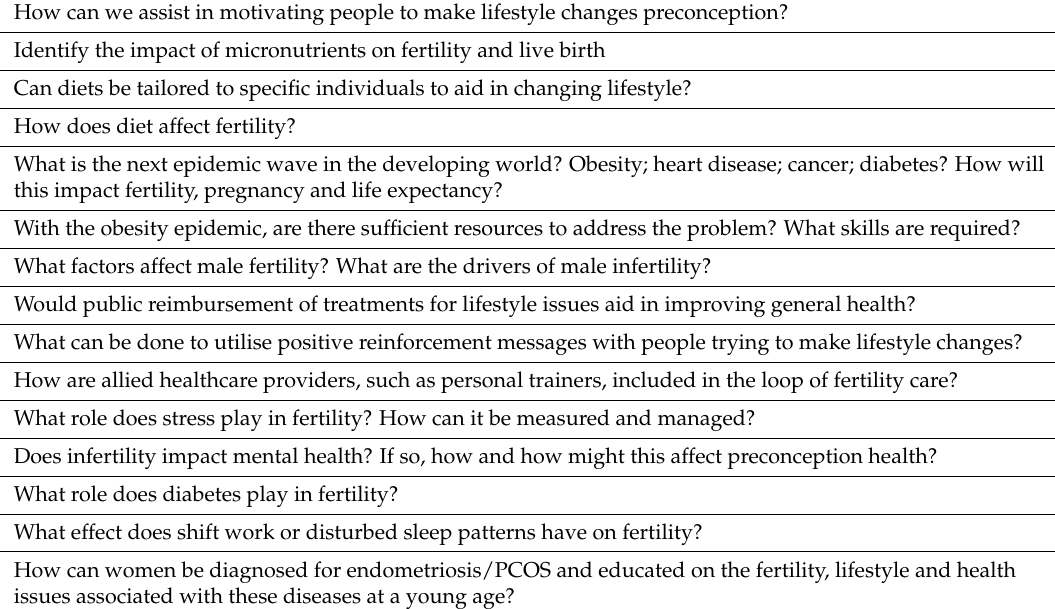
Table 1. Lifestyle-related factors and preconception health and